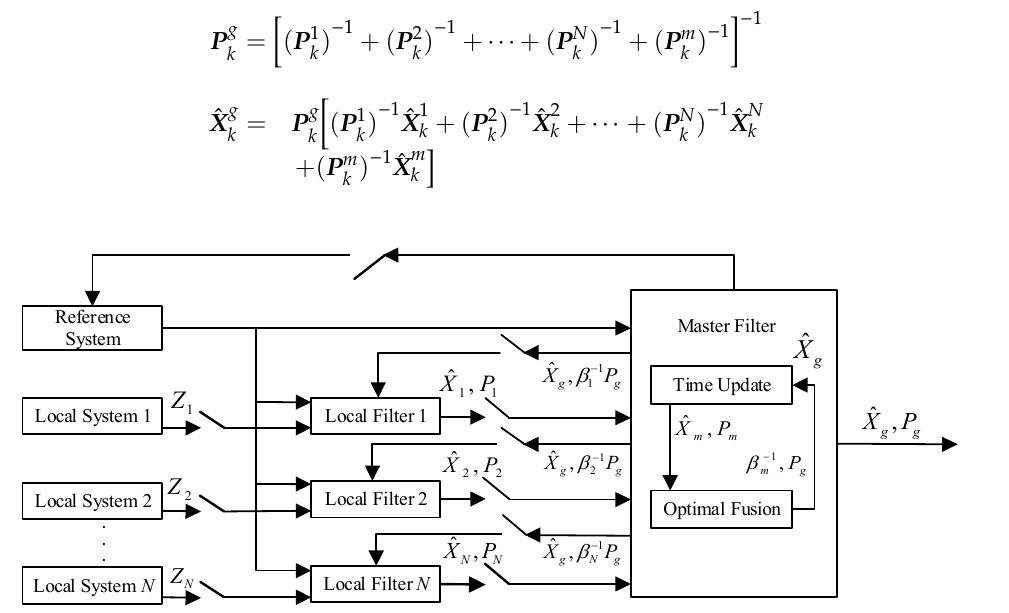
Figure 1. The schematic diagram of the federated Kalman filter.